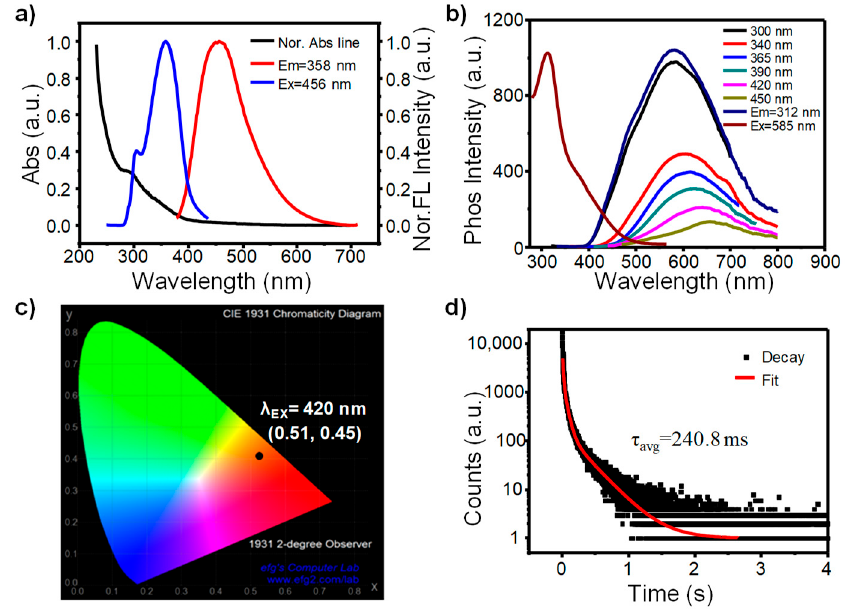
Figure 2. ( a ) The UV-Vis absorbance (black line), fluorescence (FL) emission (red line), and FL excitation (blue line) spectra of the AA-CDs water dispersion (1 mg/mL). ( b ) RTP emission spectra at different excitation wavelengths and excitation spectrum at the emission of 585 nm of the AA-CDs powder at ambient conditions. ( c ) CIE chromaticity coordinates of the AA-CDs powder under the excitation at 420 nm. ( d ) RTP decay spectrum and fitting curve (red line) of the AA-CDs powder at ambient conditions.